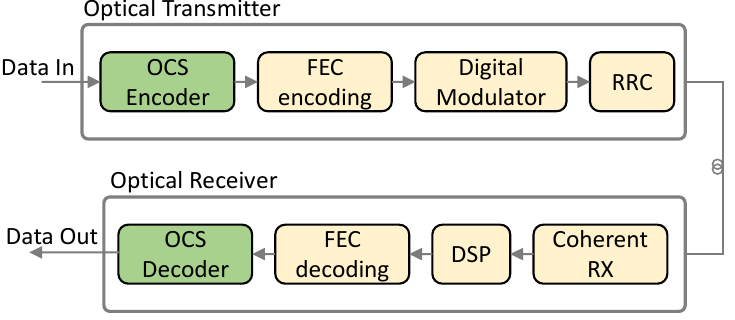
Figure 3. Optical communication system for OCS.